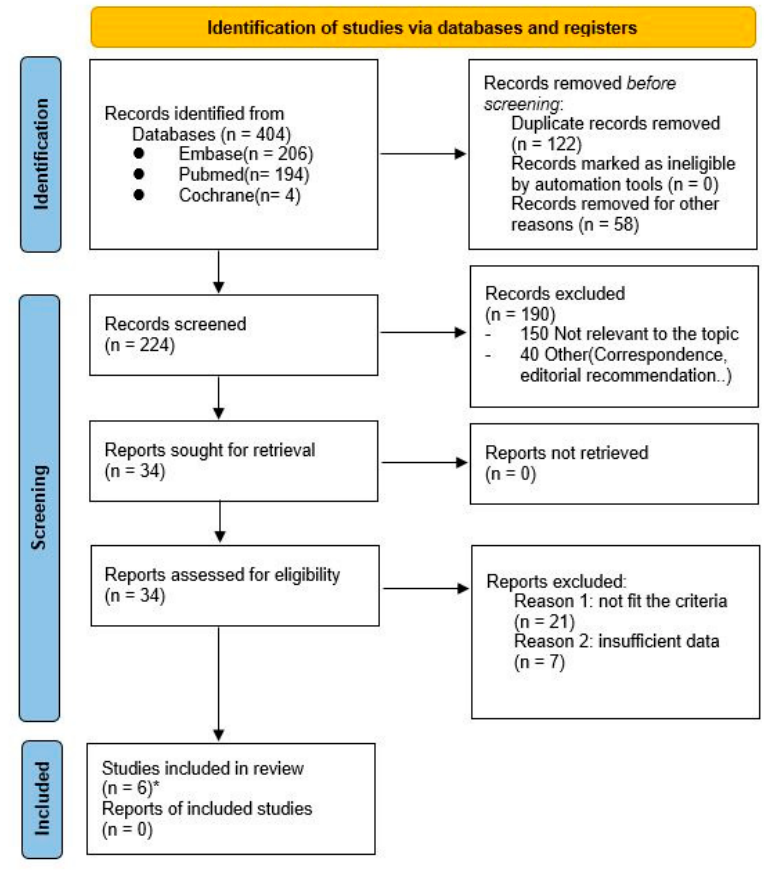
Figure 1. PRISMA 2020 flow diagram for new systematic reviews.